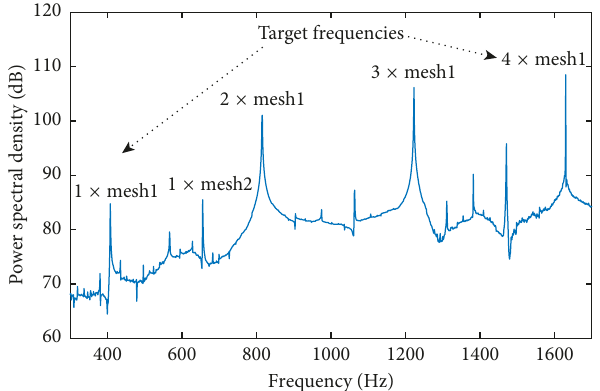
Figure 8: Vibration signal of gear